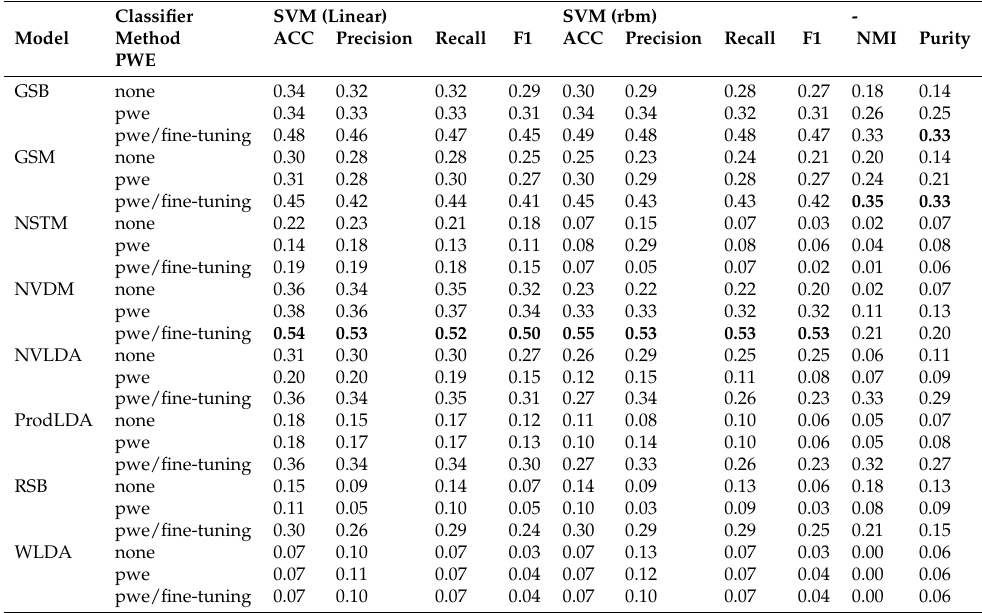
Figure 6. Classification and clustering performance. Table 23. Classification and Clustering performance on